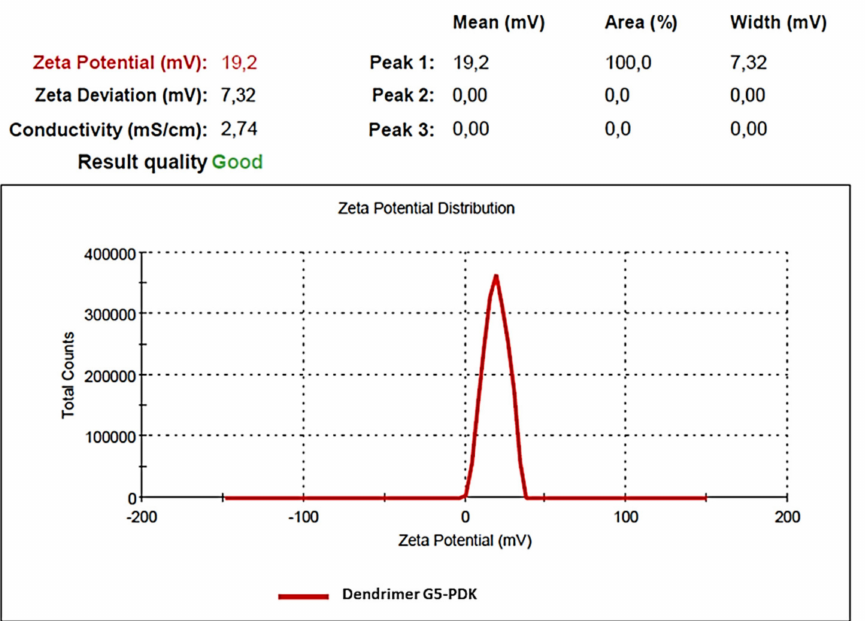
Figure 6. Representative distribution of G5-PDK ζ